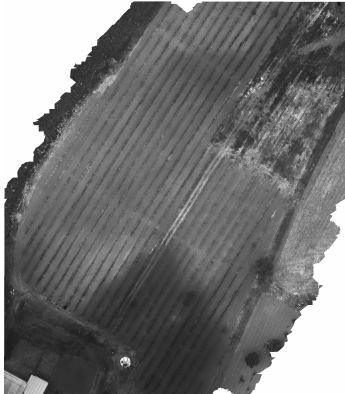
Figure 27. Orthomap generated from single band, in this case the blue band, obtained from MicaSense camera. Two consecutive points are distanced approximately 0.2 m apart from each